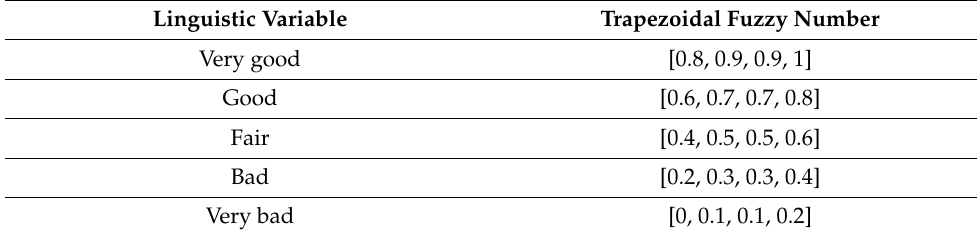
Table 1. The linguistic variables and trapezoidal fuzzy numbers.